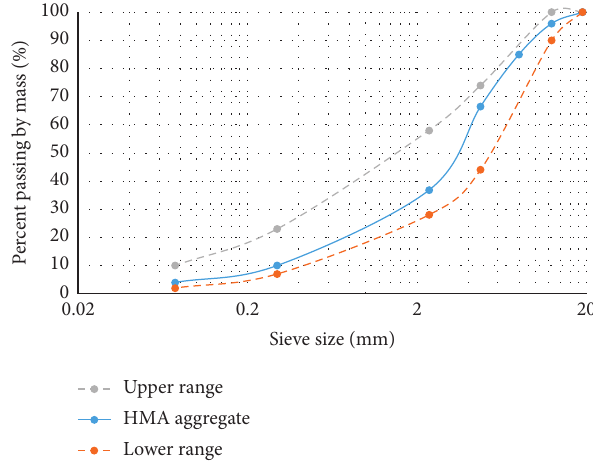
Figure 1: Granulation of consumable aggregate materials. Table 1: Physical characteristics of